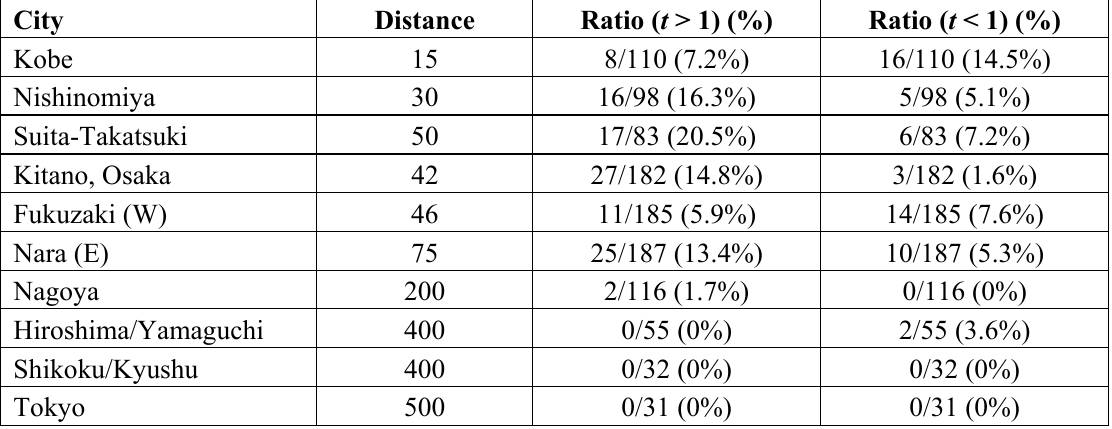
Table 1. The wake-up ratio and percentage of pupils who lived at various distances (km) from the epicenter and the time of waking, t , (in minutes) before the Kobe Earthquake. City Distance Ratio ( t > 1) (%) Ratio ( t < 1) (%) Kobe 15 8/110 (7.2%) 16/110 (14.5%) Nishinomiya 30 16/98 (16.3%) 5/98 (5.1%) Suita-Takatsuki 50 Kitano, Osaka 42 Fukuzaki (W) 46 Nara (E) Nagoya 200 2/116 (1.7%) Hiroshima/Yamaguchi 400 0/55 (0%) Shikoku/Kyushu 400 Tokyo 500 0/31 (0%) 0/31 (0%) Nearly 1,100 responses were